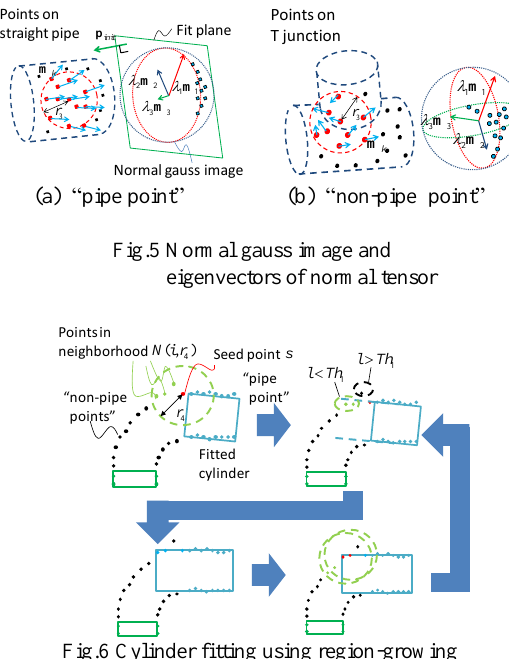
Fig.6 Cylinder fitting using